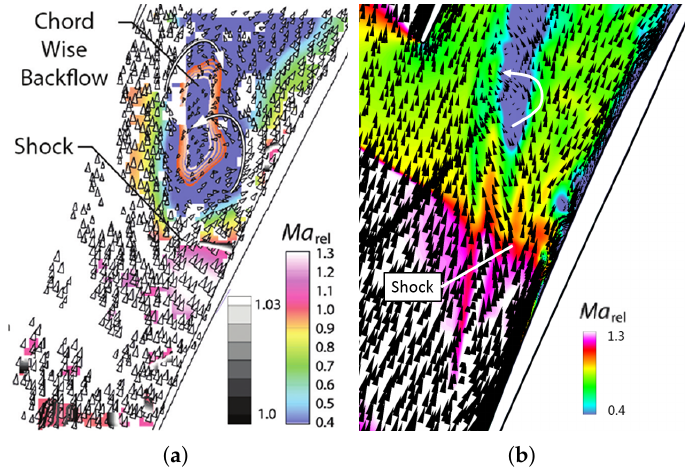
Figure 19. Spiral vortex breakdown at NS.. ( a ) PIV results [46]; ( b ) DES results in the present